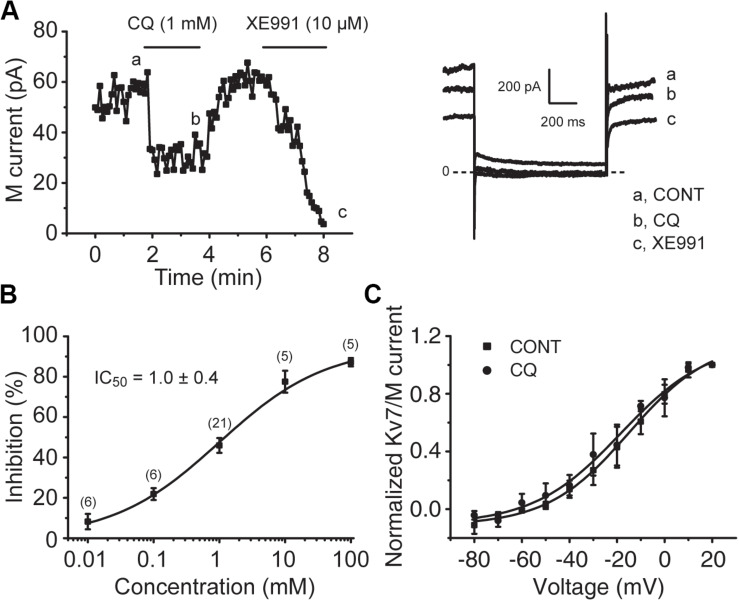
CQ inhibits M/Kv7 currents in mice DRG neurons. (A) Representative time course of CQ (1 mM)-induced inhibition of M/Kv7 currents (left). Current traces are shown (right). XE991 (10 μM) was used as positive control to inhibit M/Kv7 currents. (B) The concentration–effect relationship curve for CQ-induced inhibition of M/Kv7 currents is shown. IC50 = 1.0 ± 0.4 mM (n = 6, 6, 21, 5, 5 at each concentration of CQ, respectively). (C) CQ (1 mM) has no significant effect on current–voltage (I–V) curve of M/Kv7 channel. The statistical significance was evaluated using one-way analysis of variance followed by Dunnett’s post-hoc test for multiple comparations.